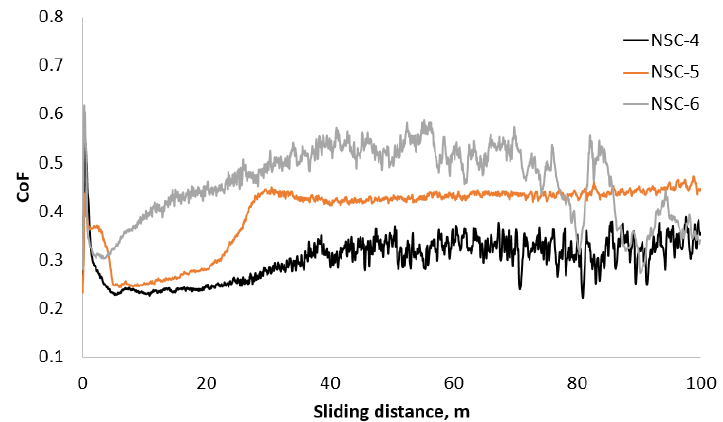
Figure A4. CoF curves for Nb-doped samples.